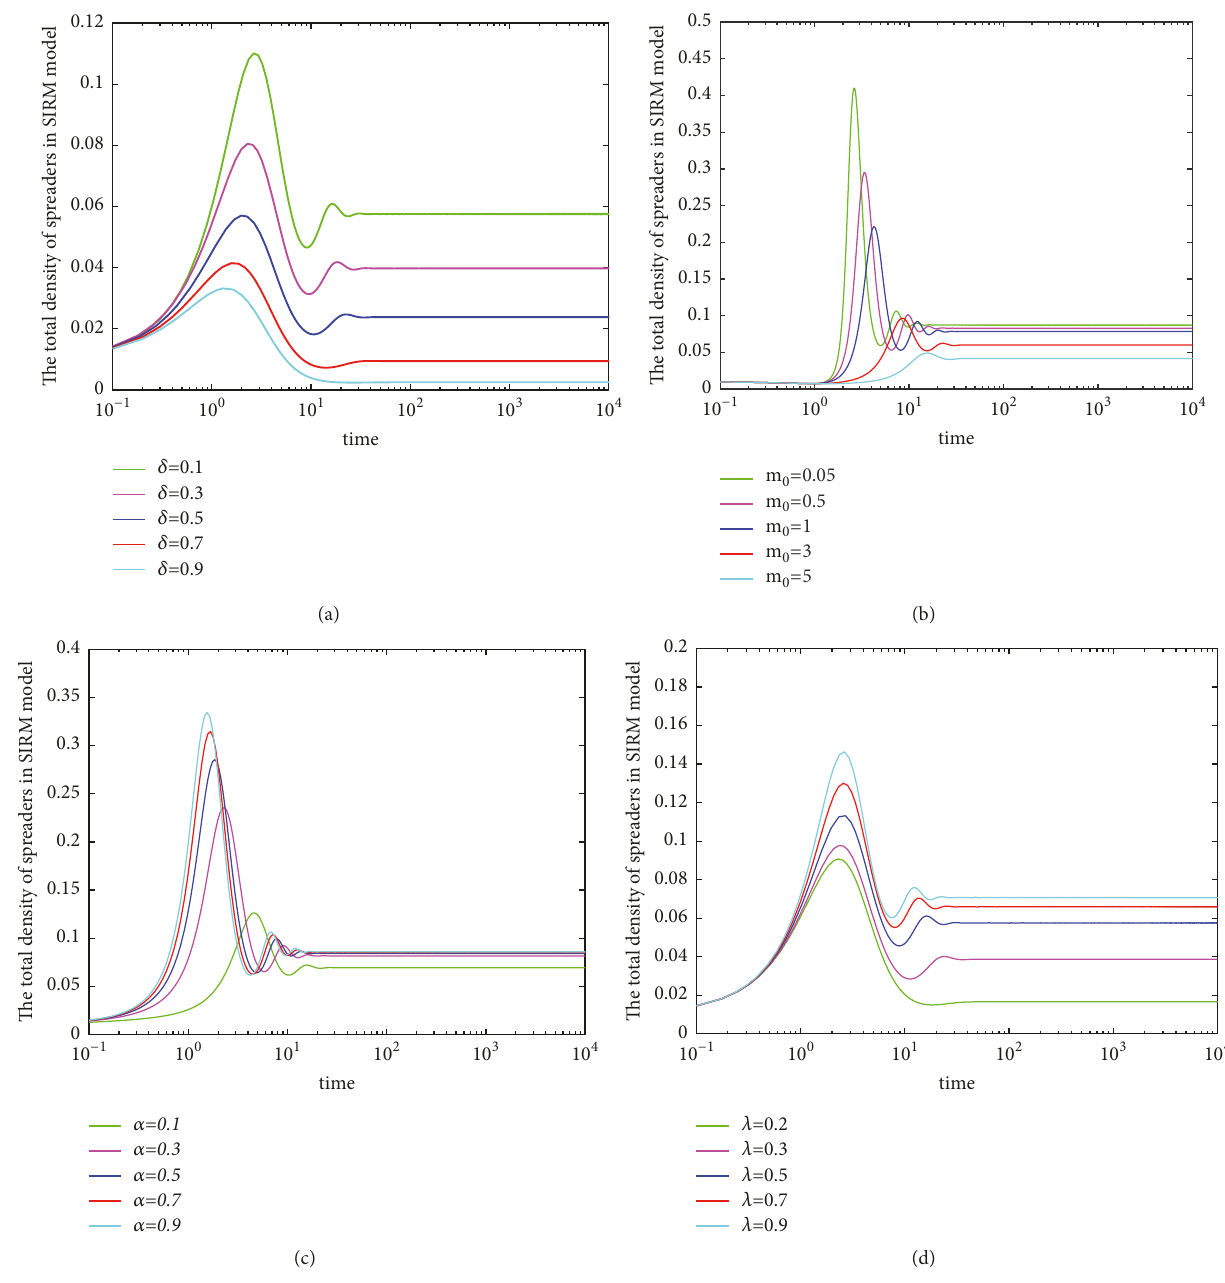
Figure 4: The impact of different values of 𝛿,𝑚 0 , 𝛼, 𝜆 on the total density of spreaders when R 0 > 1 . Table 1: Relevant parameter